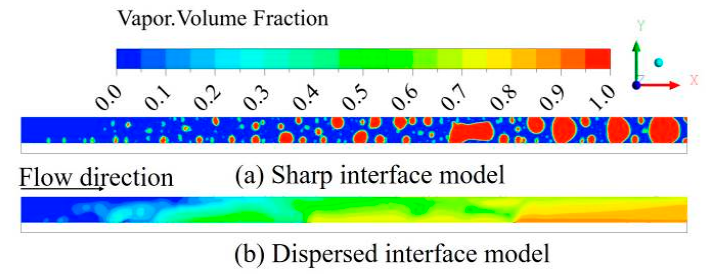
Figure 4. Vapor volume fraction at the symmetrical section of channel for di ff erent interface models.